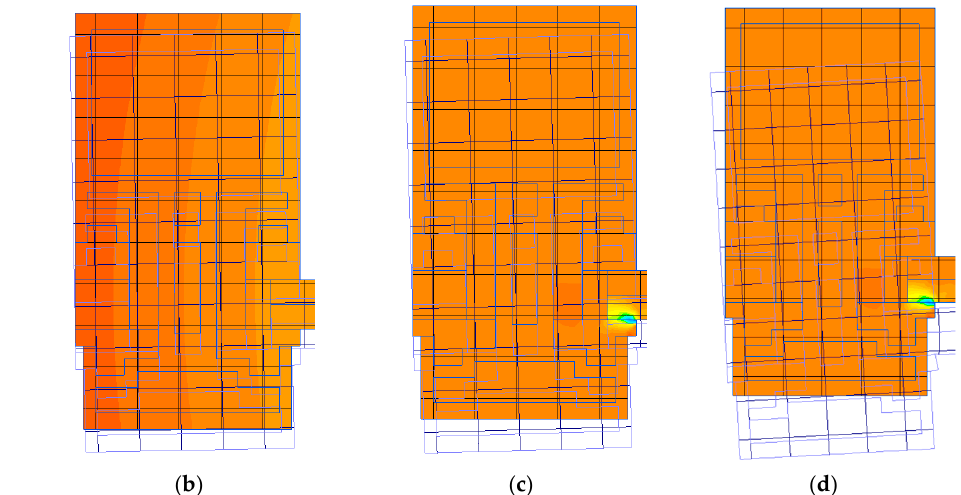
Figure 11. Deformations of the steel profile assembly as part of the insulating glass unit of samples No. 2.1–No. 2.3 while under the action of a thermal load at ( a ) 5 min, ( b ) 15 min, ( c ) 30 min, and ( d ) 45 min.